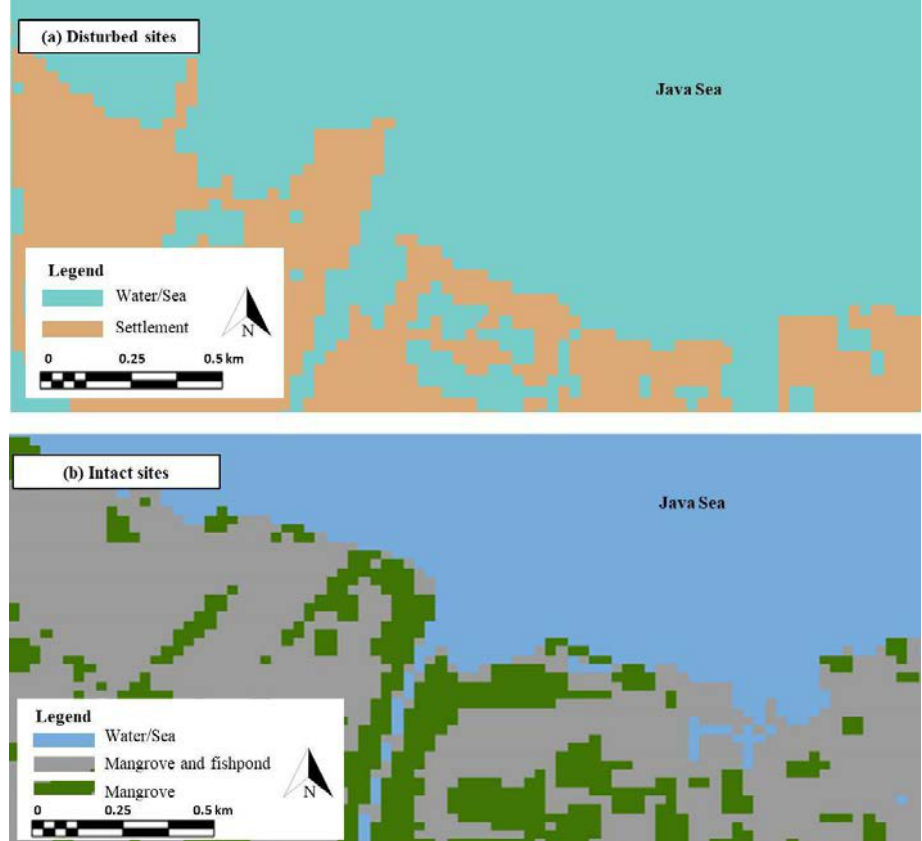
Fig. 2: Land-use classifications at disturbed and intact sites on West Java Fig. 2: Land‐use classifications at disturbed and intact sites on West Java coast